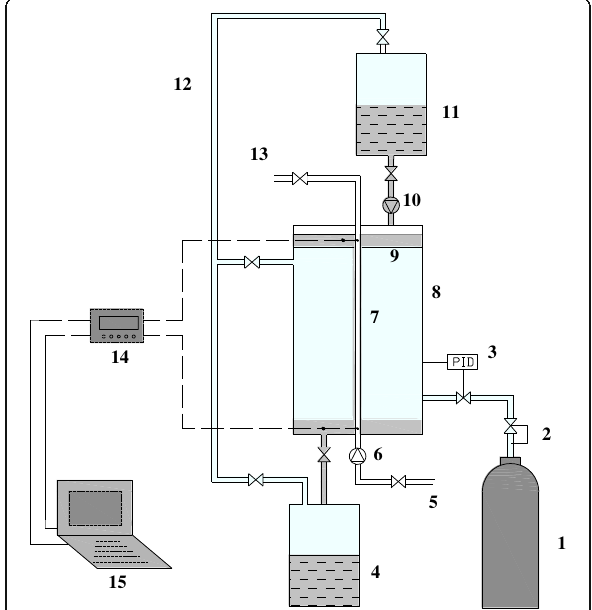
Fig. 11 Schematic diagram of the experimental system for NH 3 – H 2 O nanofluid falling film absorption [117]. 1 NH3 vessel, 2 decompression valve, 3 constant pressure controller, 4 , 11 container of solution, 5 inlet of cooling water, 6 , 10 constant flow controller, 7 falling film tube, 8 visible absorber body, 9 solution distributor, 12 tubes for balancing pressure, 13 outlet of cooling water, 14 HP data acquisition instrument, 15